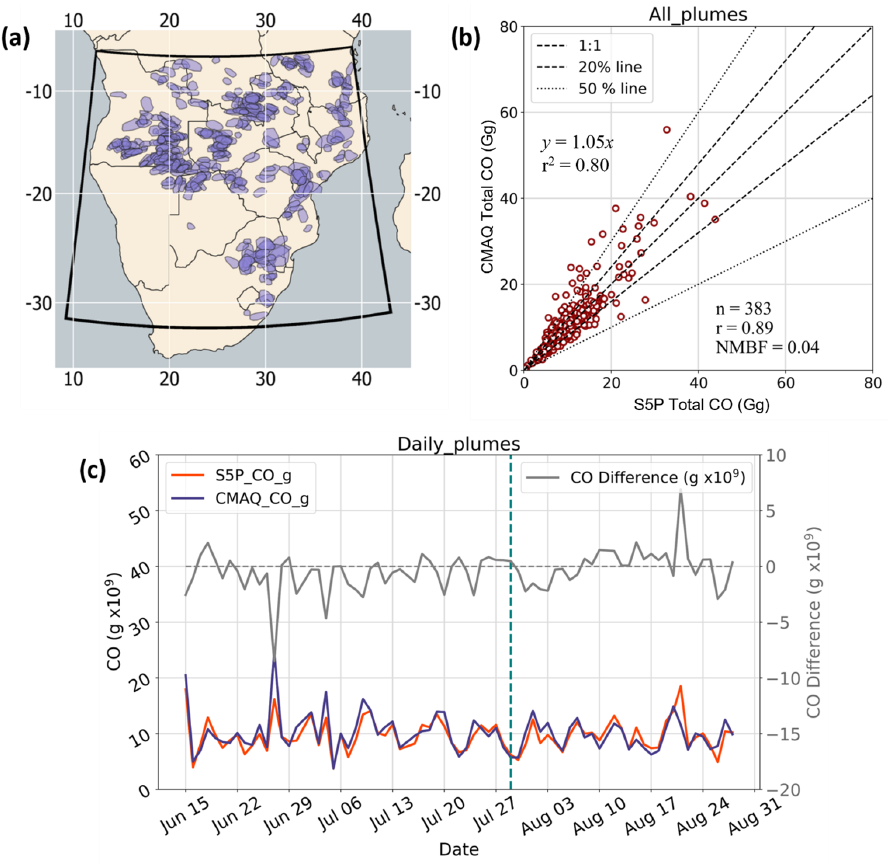
Figure 11. Evaluation of FREM-derived CO emissions based on WRF-CMAQ modelling. (a) Model domain and the bounding polygons of 383 plumes identified in the S5P TCCO product between 15 June and 29 August 2019 used in the evaluation. (b) Relationship between modelled and observed total in-plume CO for the individual smoke plumes identified in (a) . Pearson’s correlation and NMBF of the dataset are shown, along with dotted lines indicating the 1 : 1, ± 20% and ± 50% relationships. The NMBF of 0.04 indicates a 4% mean overestimation by the model compared to the observations. (c) Summed total CO from all plumes observed on each day of the simulation as determined by CMAQ (purple) and S5P (red), with their difference represented by the grey line (right-hand-side y axis). The vertical dotted line on 29 July indicates the start of the second simulation period (see main